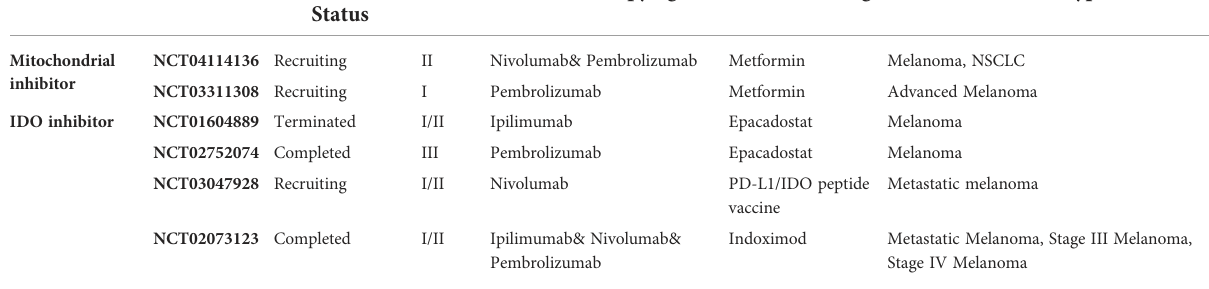
TABLE 3 List of clinical trials combining metabolic drug and immunotherapy in melanoma. Clinical trial